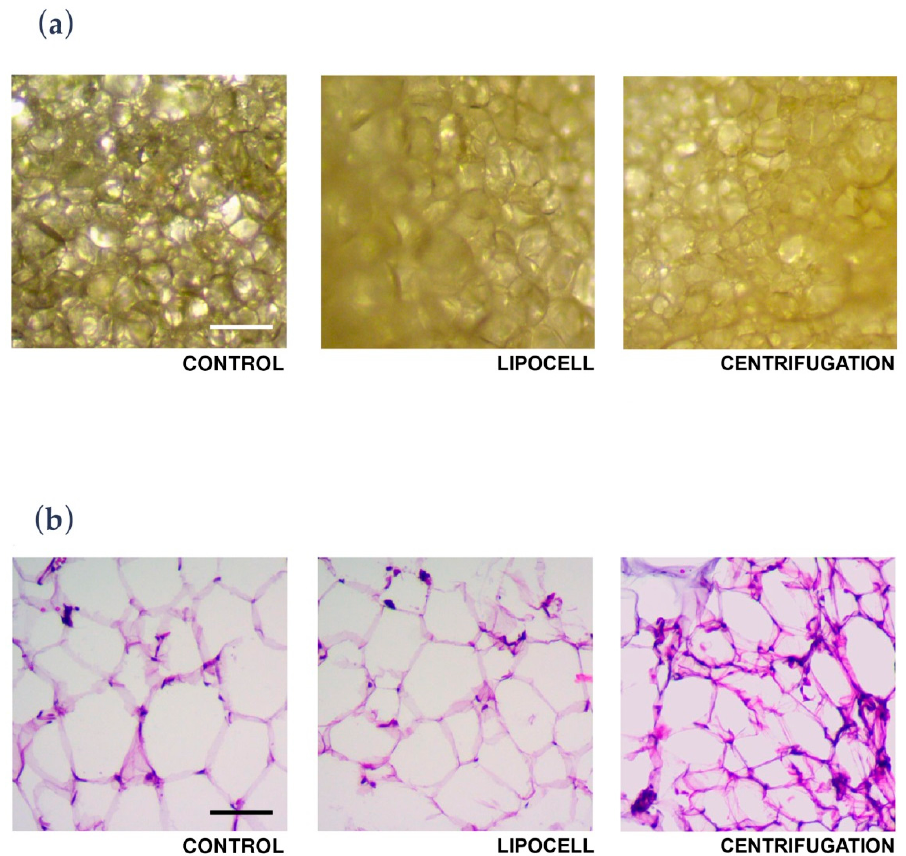
Figure 3. ( a ) Representative images of adipose tissue clusters. Bar = 200 µm. ( b ) Representative images of H&E staining of dehydrated adipose tissue sample sections. Bar = 100 µm.